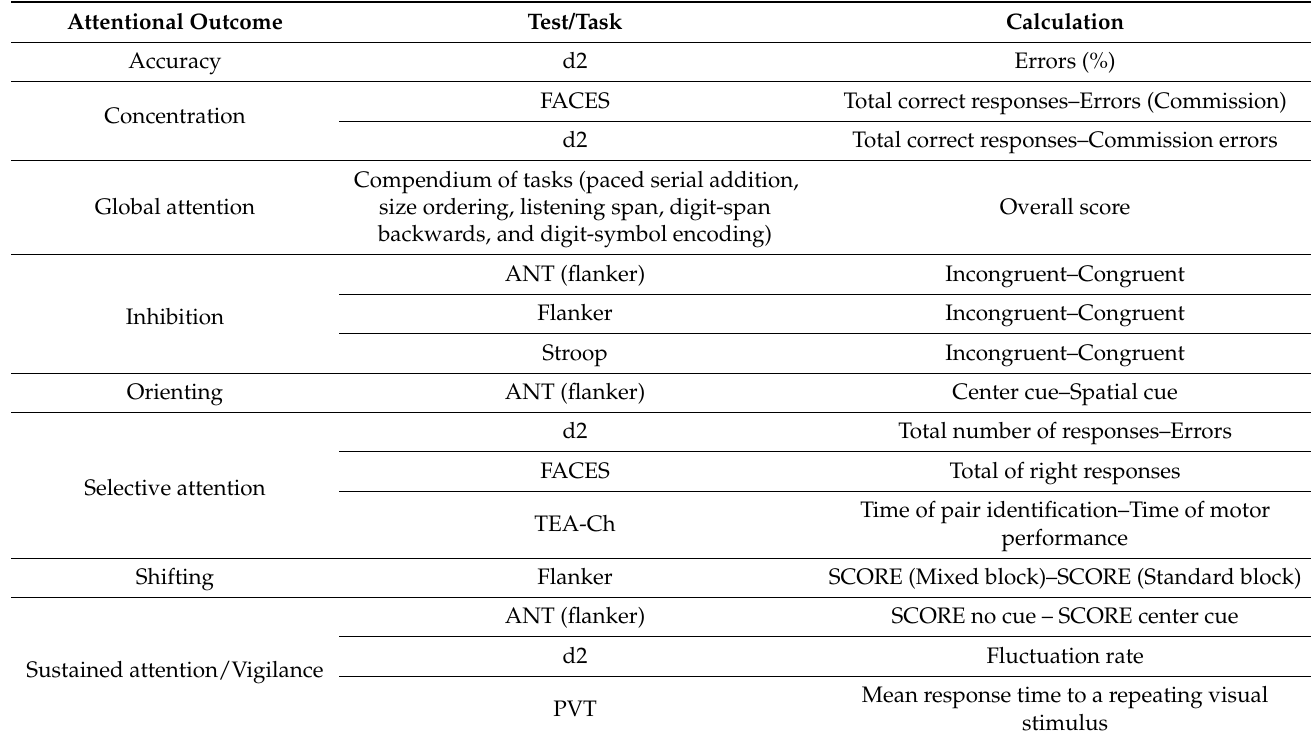
Table A3. Protocols of